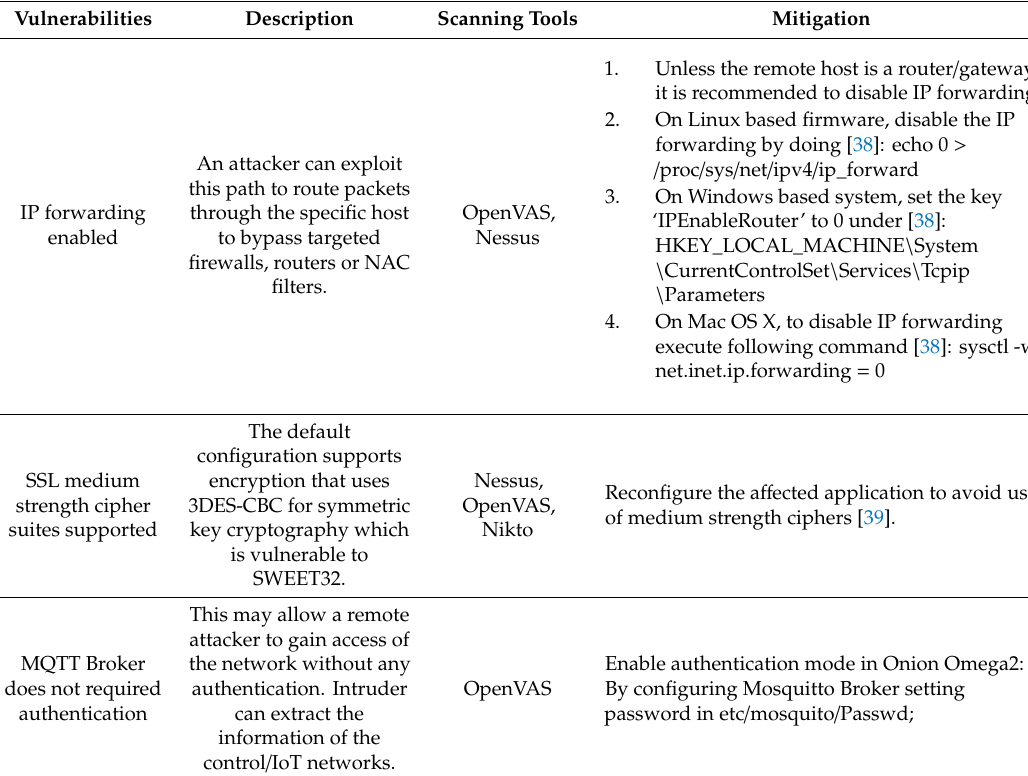
Table 4. Onion Omega2—network administrator fixes. message queue telemetry transport =